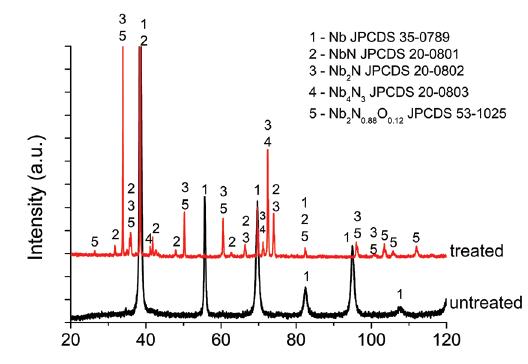
Figure 5. Diffractogram of as-implanted Nb sample via pulses of 10kV/20 μ s/500Hz, for